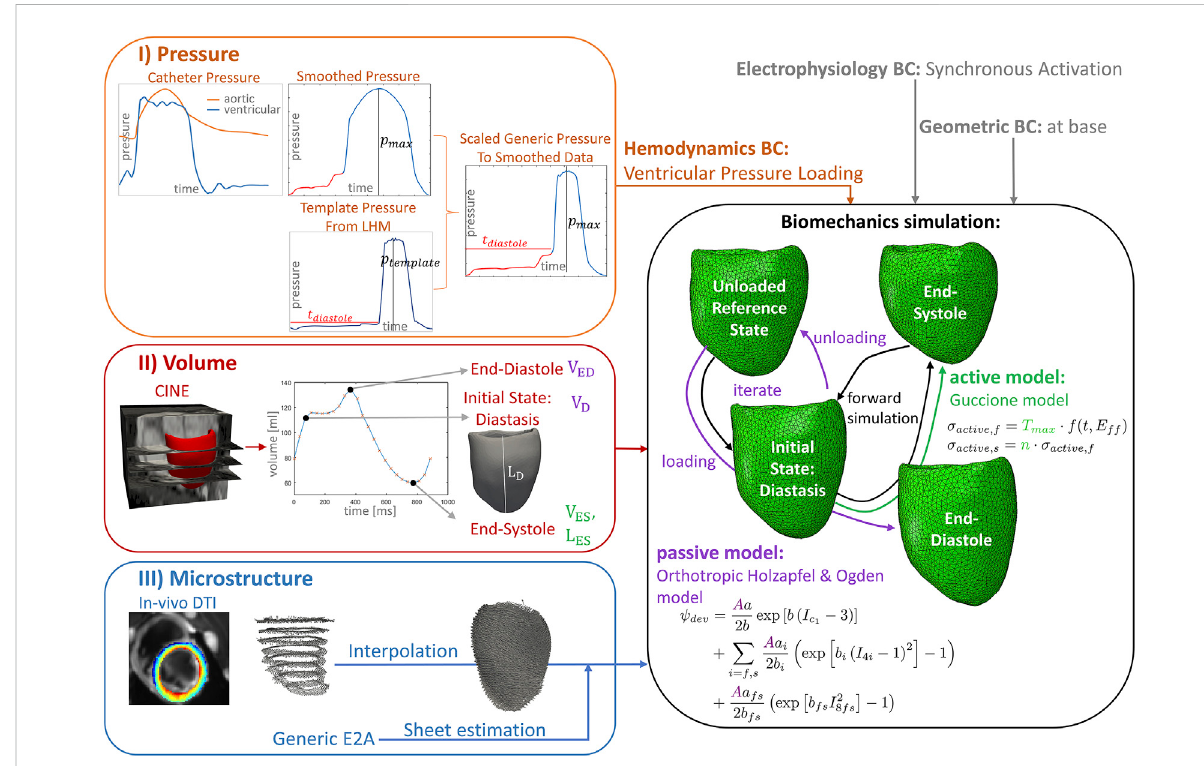
FIGURE 1 Work fl ow of the data assimilation and personalization process for a left-ventricular biomechanics model of one porcine heart. I) (orange box) Ventricularand aorticcatheter pressure measurements are combined and smoothed. The diastolic pressure traceand themaximal systolic pressure value are extracted to personalize a template pressure curve extracted from the underlying Living Heart Model (LHM), while keeping the duration of diastole, systolic pressure increase, and pressure decrease of the template pressure curve constant. This pressure trace provides the hemodynamic boundary condition for the simulation (orange input). II) (red box) The volume over the cardiac cycle is extracted from cine images using tracking. The mesh extracted in diastasis is used as initial state for the simulation. End-diastolic and diastatic volumes are used to adapt the passive model parameters by scaling the parameter A (purple) and to estimate an unloaded reference state. The end-systolic frame is used to adapt theactive model(green). The end-systolic volume is used to fi tthemaximal active tension parameter T max , theleft-ventricularlength of thisframe is used to adapt the parameter n , scaling the active stress contribution in sheet direction. III) (blue box) The predominant aggregated myocyte orientation is measured with in-vivo cDTI in eight short-axis slices. Four interpolation techniques are applied to obtain a 3D fi ber fi eld on the 3D mesh. The sheet direction is estimated to reach a diastolic E2A angle of 13 ° (Nielles-Vallespin et al., 2017). The biomechanics model uses the LHM implementation(Baillargeonetal.,2014)ofthepassiveorthotropicHolzapfelandOgden(HolzapfelandOgden,2009)materialmodelandtheactive Guccione model (Guccione et al., 1995). The reference geometry is estimated by unloading the initial state using a suction problem and subsequent loading to end-diastole. This procedure (purple arrows) is repeated while iterating over the passive material scaling (A). The volume after loading is comparedtothedataattheloadingconditionoftheinitialdiastaticpressureandatend-diastole.Thesumofthesevolumeerrorsservesasobjective functiontoidentifytheunloadedreferenceandpassivescalingparameterestimates.Thesimulationoverthecardiaccycleisperformedstartingfrom the unloaded reference (black